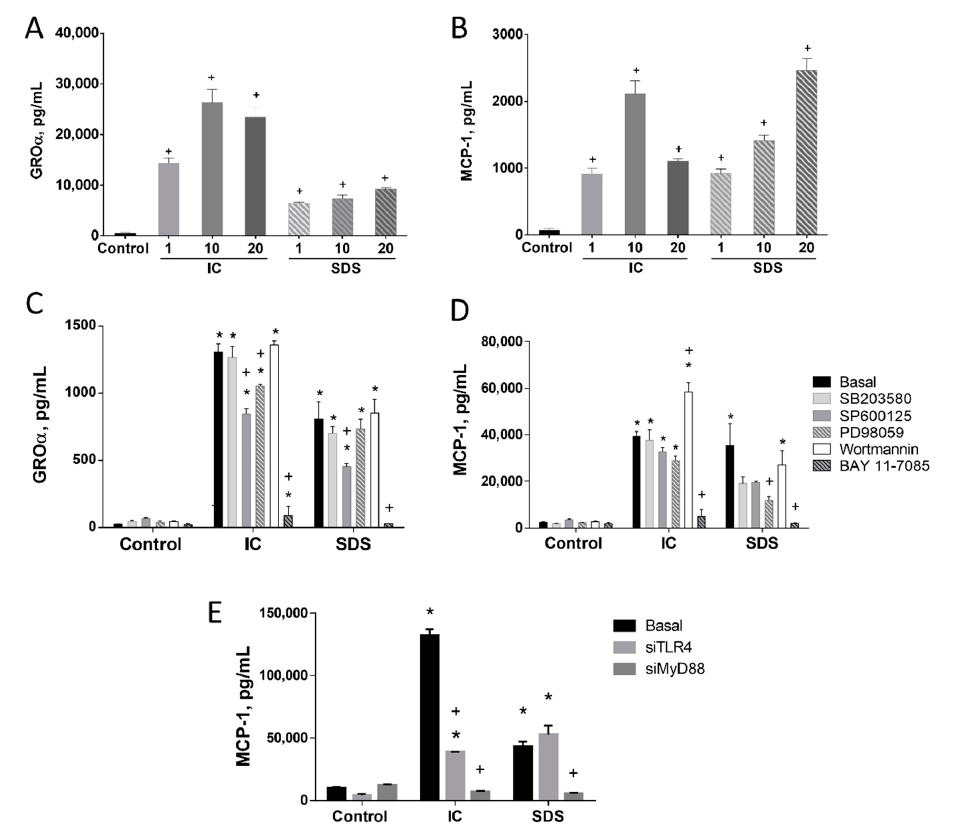
Figure 1. Effect of IC and SDS on cytokine production by IEC18 intestinal epithelial cells. Confluent monolayers were incubated for 24 h with immunoglobulin concentrate (IC) or spray-dried serum (SDS) at 1, 10, and 20 mg/mL and growth-related oncogene α (GRO α , ( A )) or monocyte chemoattractant protein (MCP-1, ( B )) were measured in the supernatant by ELISA. To assess the mechanism inhibitors for p38 MAPK (SB203580, 10 µM), JNK (SP600125, 10 µM), ERK1/2 (PD98059, 10 µM), phosphatidylinositol 3-kinase (wortmannin, 1 µM) or NF- κ B (Bay 11–7085, 10 µM) were added to confluent IEC18 intestinal epithelial monolayers 2 h before the addition of IC or SDS (10 mg/mL) and GRO α ( C ) and MCP-1 ( D ) were measured in the 48 h supernatant by ELISA. ( E ) Effect of MyD88 and TLR4 gene silencing on IC and SDS-induced MCP-1 secretion in IEC18. Cells were cultured with IC and SDS (both, 10 mg/mL) for 24 h and MCP-1 was measured in the culture medium by ELISA. Data are represented as mean ± SEM and are representative of two independent experiments ( n = 3–4). * p < 0.05 vs. the corresponding Control group; + p < 0.05 vs. the corresponding Basal (no inhibitor or control vector) group. Results are represented as mean ± SEM and are representative of two independent experiments ( n =